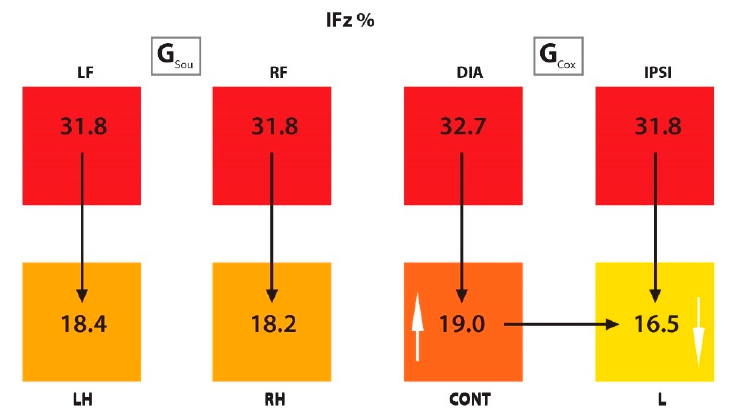
Figure 4. Scheme representing the IFz% of the limbs from G Sou and G Cox . The black arrows represent a significant difference between limbs within groups (for example, in G Cox , there was a difference between CONT and L limbs), and the white arrows, between groups (for example, there was a difference between G Sou and G Cox in LH/CONT and RH/L limbs). The color scale within each group: higher values are represented in darker colors and lower values in lighter colors. IFz% (vertical impulse normalized as percentual of total force); G Sou (group sound); G Cox (group coxarthrosis); LF (left front limb); RF (right front limb); LH (left hind limb);RH (right hind limb); DIA (diagonal limb); IPSI (ipsilateral limb); CONT (contralateral limb); L (lame limb). 3.2.2. Comparison Between Groups The values of PFz%, IFz%, SPD (s) and TPFz%, as well as the p values comparing groups, are presented numerically in Tables 2 and 4, respectively. In the right hind limbs of sound dogs (RH, G Sou ), higher significant values for PFz%, IFz%, and an earlier occurrence of PFz% were observed when compared to G Cox . In contralateral limbs, G Cox showed a higher IFz% than G Sou . Comparing the ipsilateral limb between groups, in G Cox , PFz% was significantly higher than in G Sou . No significant differences were found between the diagonal limbs. Table 4. The p values of PFz%, IFz%, SPD (s), and TPFz% comparing limbs between the groups. Limbs